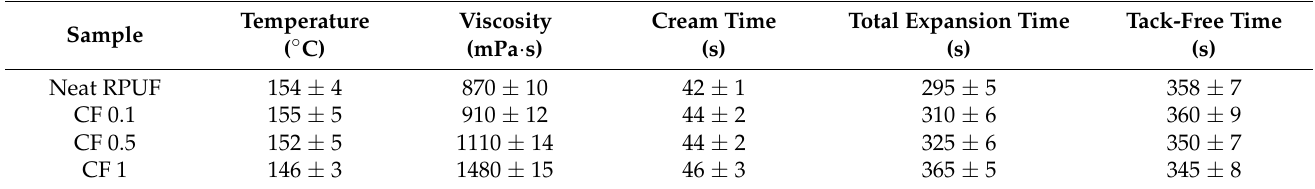
Table 1. Rheological properties and processing times for the studied RPUF.